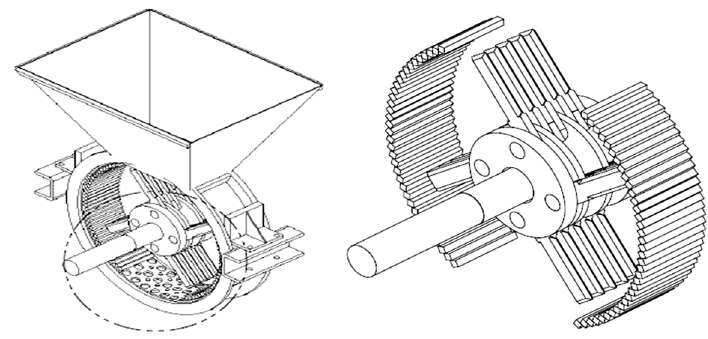
Figure 6. Drawings of the grinding unit assembly.